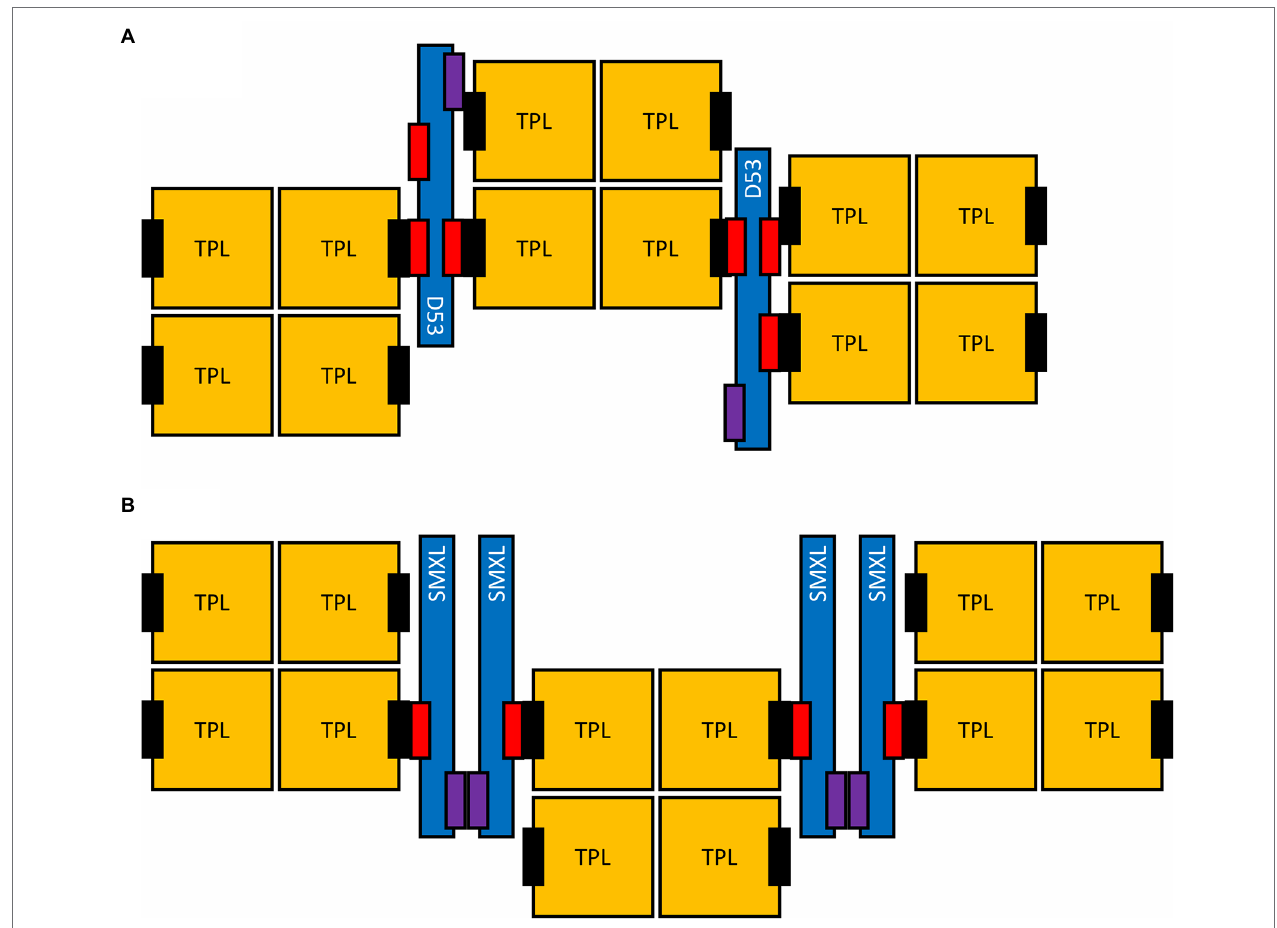
FIGURE 3 | Possible higher-order assembly of SMXL proteins and TPL tetramers. Two alternative assemblies are shown, either specific for monocotyledous D53 (A) or for SMXLs in general (B) . The EAR motifs (red) and the putative oligomerization interface on SMXL proteins (purple), as well as the CTLH domain of TPL proteins (black) are